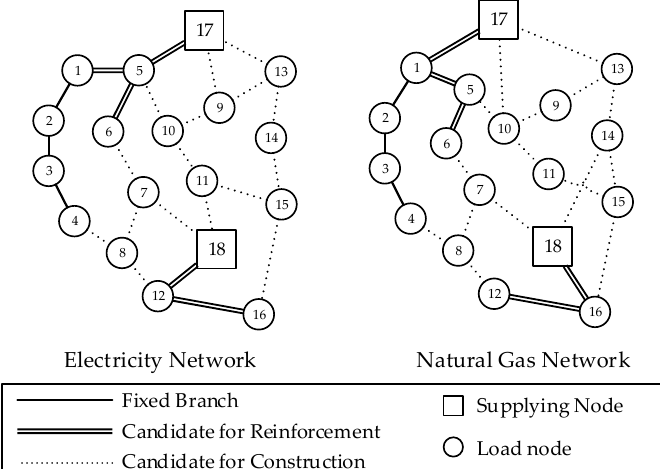
Figure 3. Diagram of the electricity and natural gas distribution networks.